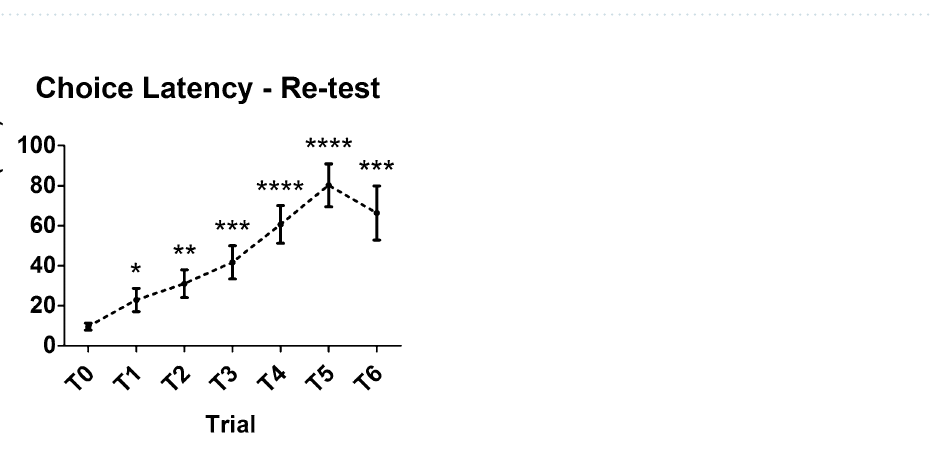
Figure 3. Choice latency of healthy wild-type mice in the test session of spontaneous alternation T-maze (intra-session effect of repetition). A significant increase of choice latency across trials of the test session was found (F 6,114 = 6.234, p = 0.0009). Asterisks highlight significant differences versus sample trial latency (* p < 0.05, ** p < 0.01, *** p < 0.001). Data are presented as mean ± SEM (n = 20).